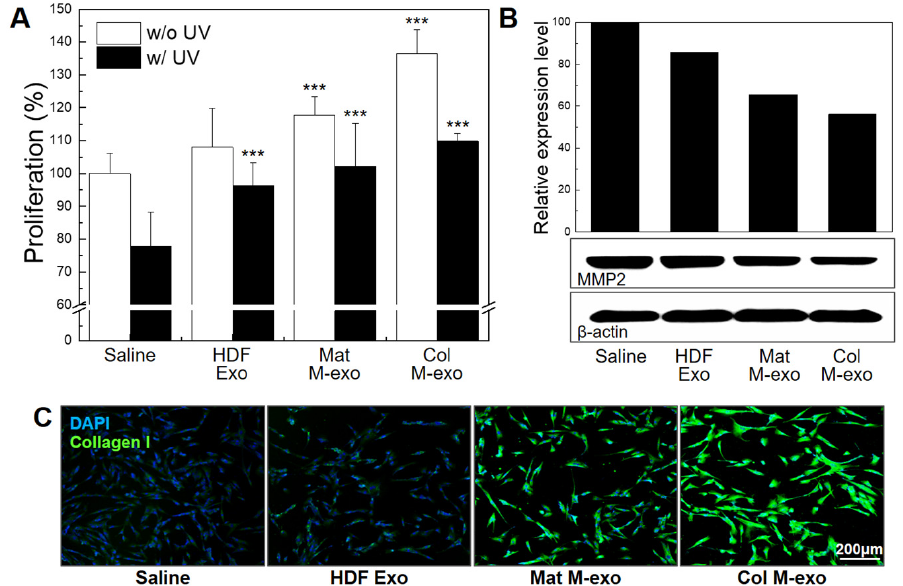
Figure 5. Skin elasticity improvement effect of milk exosomes on HDFs. ( A ) Proliferation rate of milk exosome-treated HDFs was assessed by CCK-8 analysis. n = 5; *** p < 0.001 versus saline. ( B ) Relative expression level of MMP2 proteins. ( C ) Representative immunostaining images of type 1 collagen (green) expressed in HDFs pretreated with Col M-exo for 24 h. Scale bar: 200 μ m .